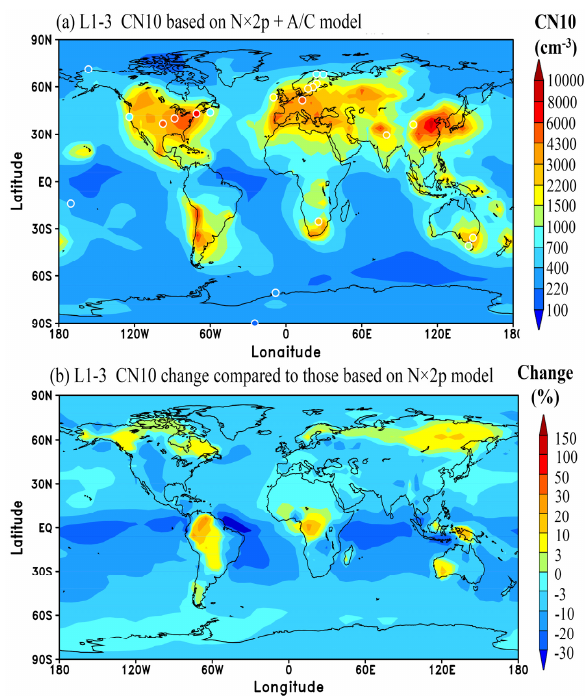
Figure 8. Fig. 8. (a) Horizontal distributions of annual mean number con- centrations of condensation nuclei larger than 10nm (CN10) in the lower boundary layer (0–0.4km) simulated with the N × 2p+A/C model described in this paper. The observed annual or multiple year averaged CN10 values from 21 sites are also overlapped on the plots for comparison. See text for the sources of the data. (b) Percentage change in CN10 compared to the case without oxidation aging and LV-SOG condensation (i.e., original N × 2p model).